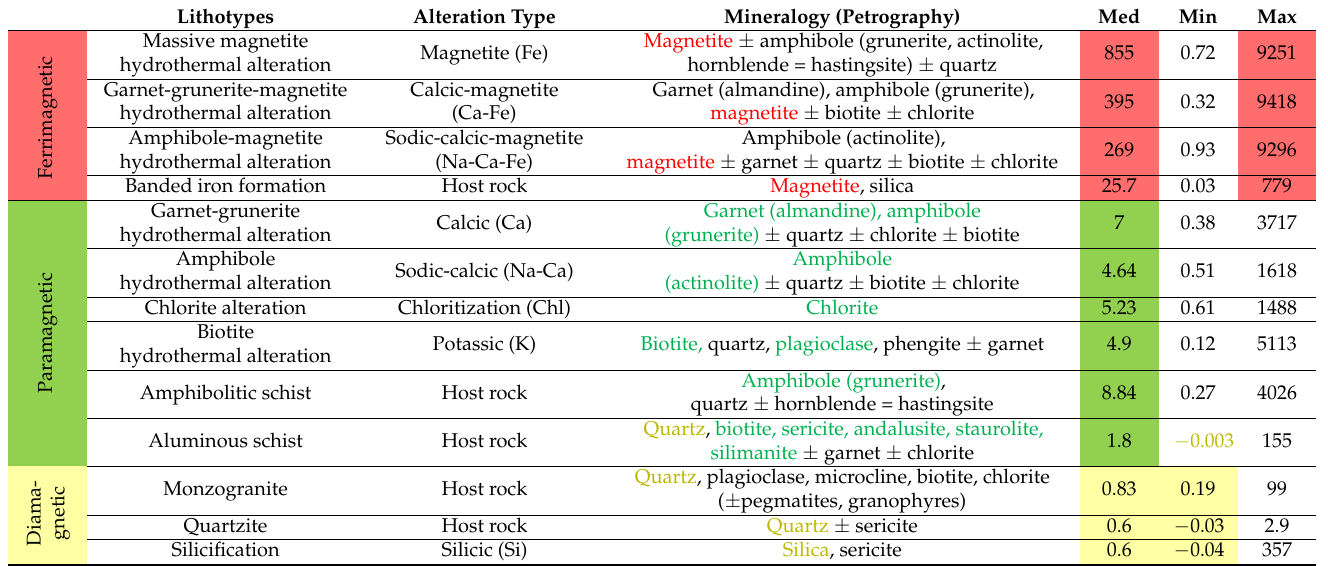
Table 1. Magnetic susceptibility (SI × 10 − 3 ) statistics associated with mineralogy, lithotypes and hydrothermal alteration zones. The predominant associated minerals are in the same color of magnetic mineral classes and their representative magnetic susceptibility values. Med: Median, Min: Minimum, Max: